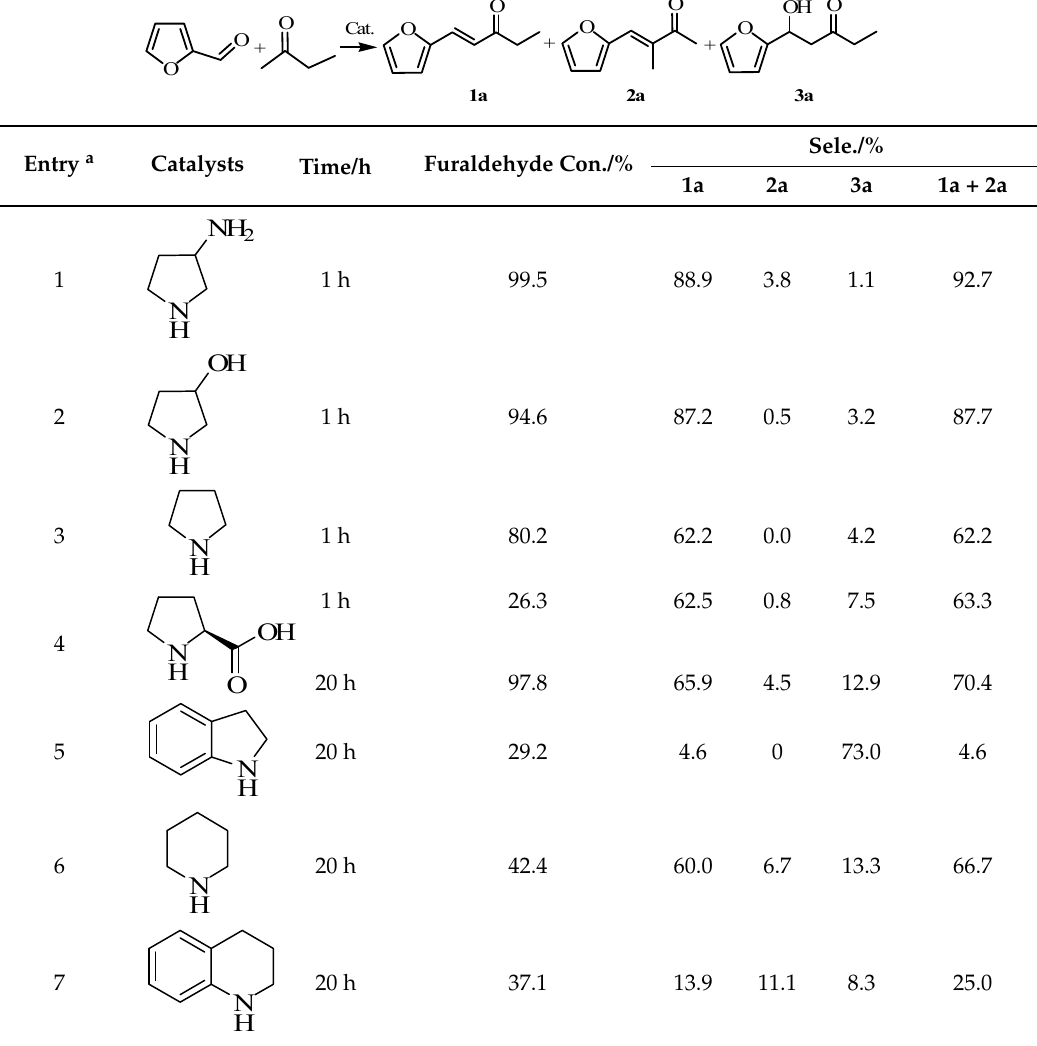
Table 1. Catalytic activity of different cyclic secondary amines on the aldol condensation of furaldehyde and butanone. O O Cat. O + O